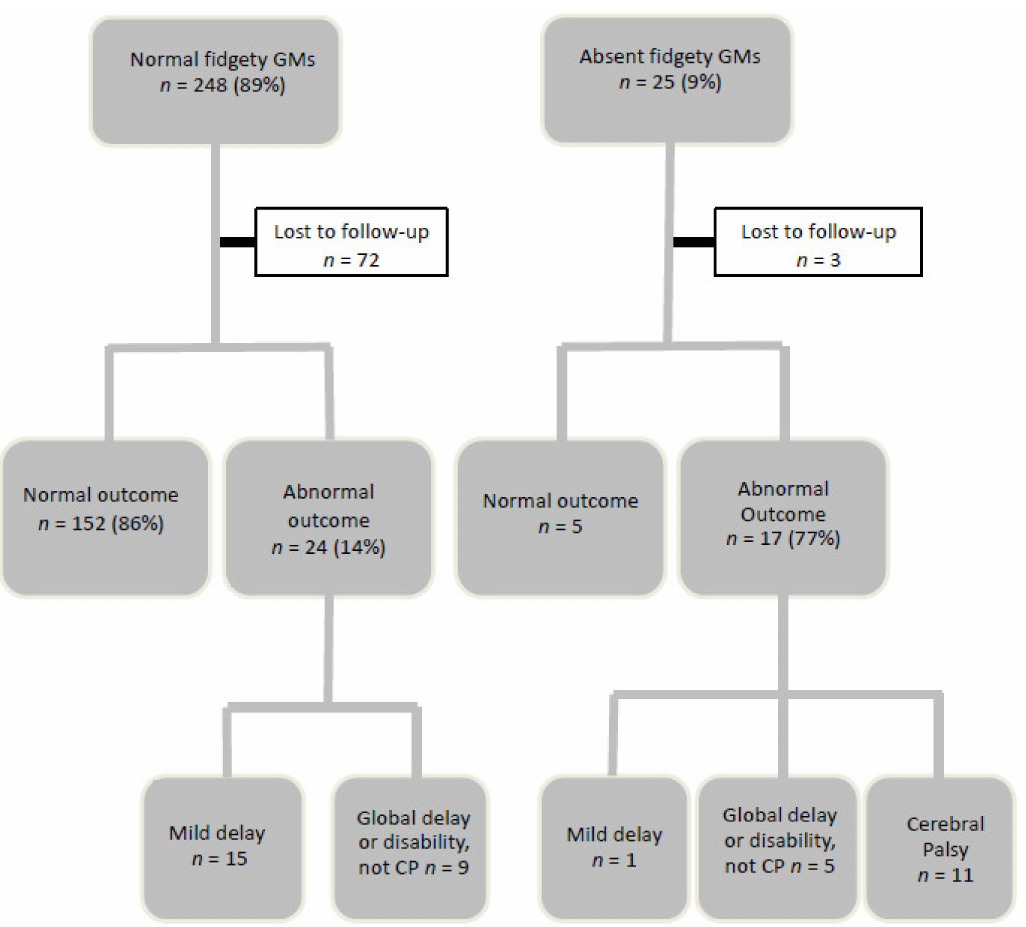
Figure 2. Outcomes at 3 years of age following normal and absent fidgety